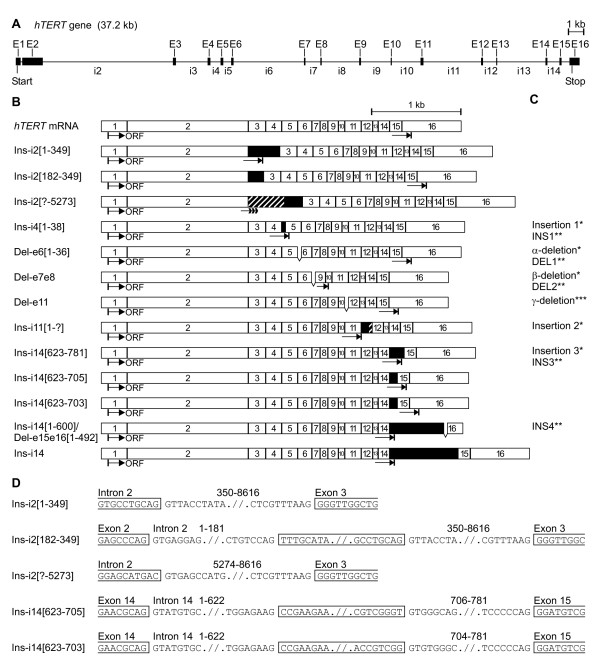
Genomic organization and ASPSs of the hTERT gene. (A) Exon/intron organization of the hTERT gene assembled from [Genbank:AF128893] and [GenBank:AF128894] [14]. Exons are shown as black boxes with numbering above. Start/Stop indicates the beginning and end of the ORF. (B) Schematic drawing of hTERT mRNA ASPSs. Exons are shown as open boxes with numbering inside. Black boxes represent intronic sequences and are cross-hatched to indicate uncharacterised 5' or 3' splice site. The ORF is indicated below each ASPS by arrows. The hTERT ASPSs have been assigned descriptive names: Ins-i, insertion of intronic sequence; Del-e, deletion of exonic sequence; followed by intron/exon number and a range of nucleotides in brackets when the insertion/deletion involves part of an intron/exon, respectively. (C) Formerly used designations: *[9], **[14], ***[15]. (D) Sequence of donor and acceptor splice sites. Unspliced sequence is boxed. Range of spliced nucleotides numbered from the first nucleotide of each intron is shown above the sequence.